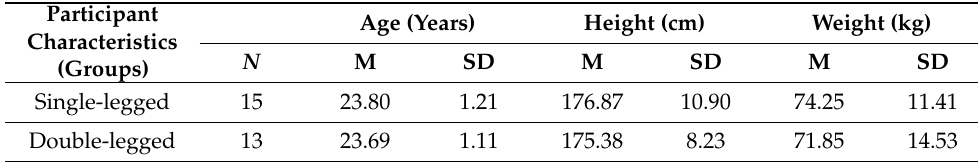
Table 1. Characteristics of the subjects (M ±